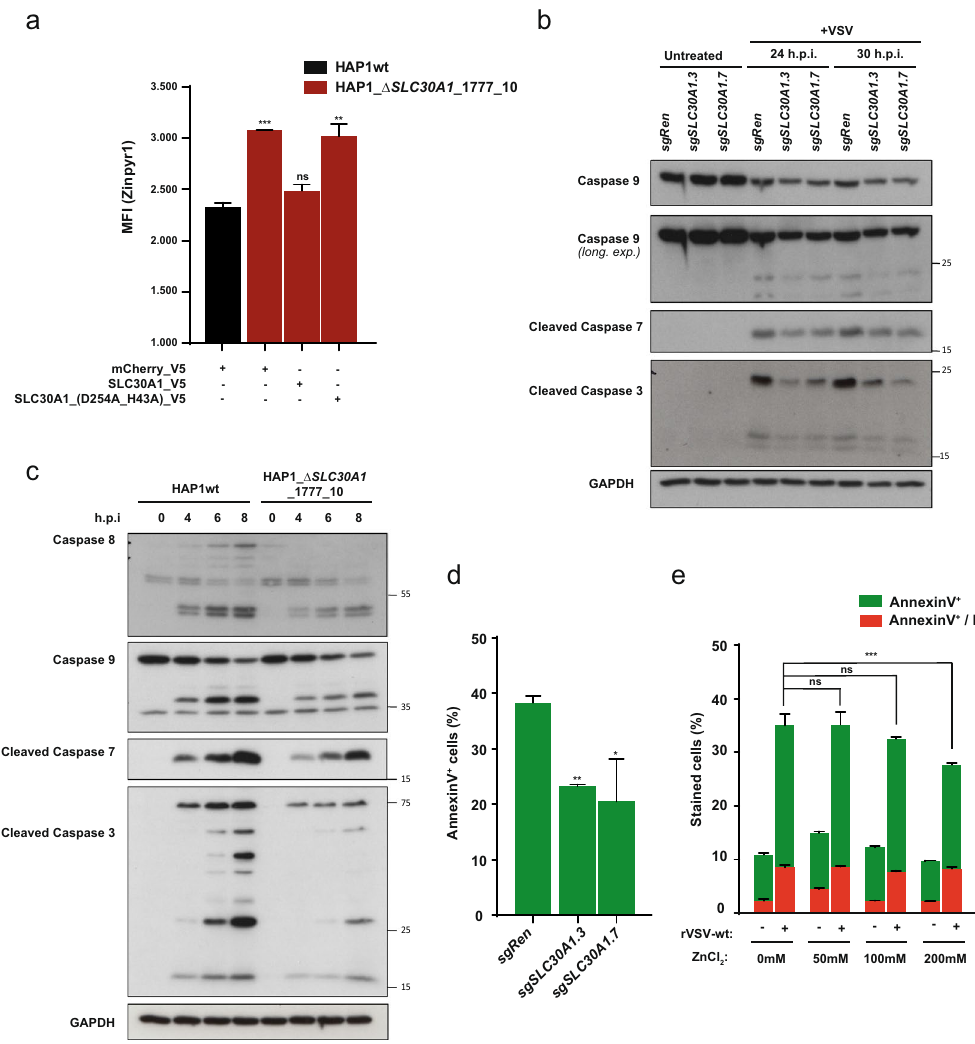
Figure 2. SLC30A1 inhibits apoptotic caspase activation via regulation of intracellular Zn 2 + levels. ( a ) Intracellular Zn 2 + levels determined using Zinpyr1 fluorescent dye. ( b , c ) Activation of pro-apoptotic caspases in VSV infected A549 ( b ) and HAP1 ( c ) SLC30A1 knockout cells. Cropped images are shown for conciseness. Full- length blots are presented in Supplementary Fig. 5. ( d ) Percentage of apoptotic cells in A549 cells expressing sgRNAs targeting SLC30A1 or Renilla luciferase after infection with VSV (MOI 2) for 24 hours, as measured with AnnexinV-FITC. ( e ) Quantification of AnnexinV- and PI-stained A549 wild type cells pre-treated with indicated concentrations of ZnCl 2 and infected with VSV-rWT (MOI 2) for 24 hours. Statistical significance was assessed using one-way ANOVA ( a , d ) and two-way ANOVA ( e ) with Dunnett’s test. Unless otherwise indicated, adjusted P-values in relation to the sgRen control or Hap1wt are shown. Data are represented as mean ± SD of one representative experiment out of at least two independent replicates. * p ≤ 0.05; ** p ≤ 0.01; *** p ≤ 0.001; ns: not